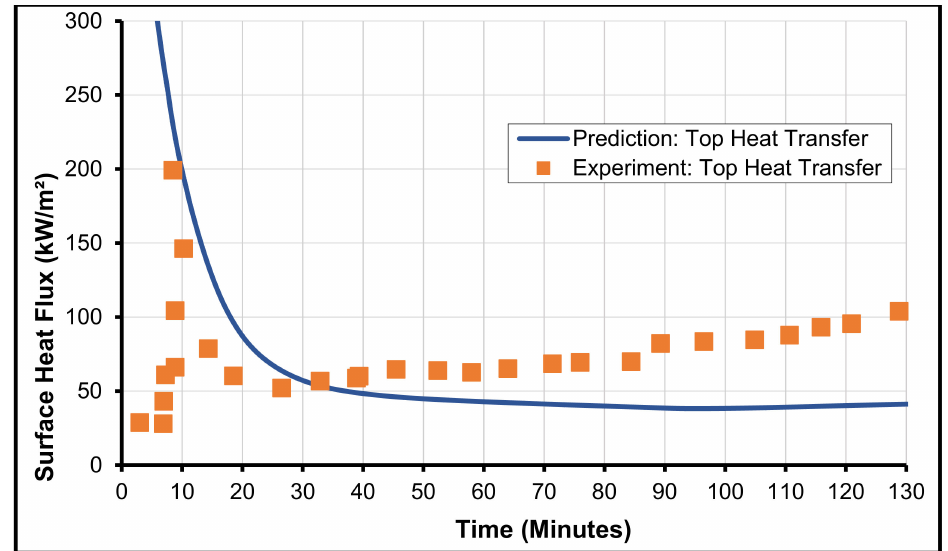
Figure 7. Comparison of SURC-2 experimental heat flux data with the developed